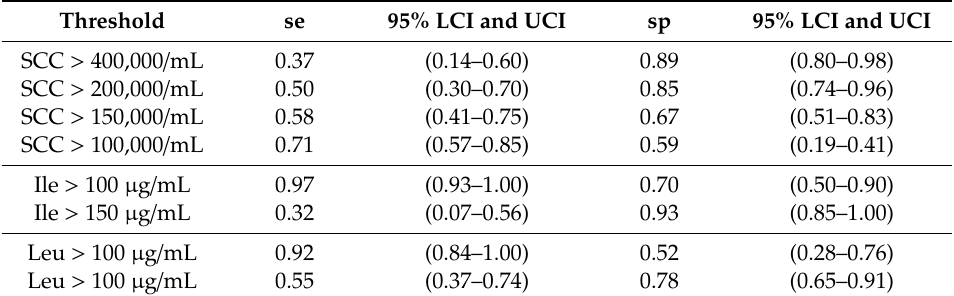
Figure 7. Bar plot for leucine content (mean and standard error) and ANOVA / Tukey-Kramer test comparing S . aureus positive and negative samples. Table 2. Sensitivity (se) and specificity (sp) with 95% lower (LCI) and upper (UCI) confidence intervals for various SCC, isoleucine (Ile), and Leucine (Leu)